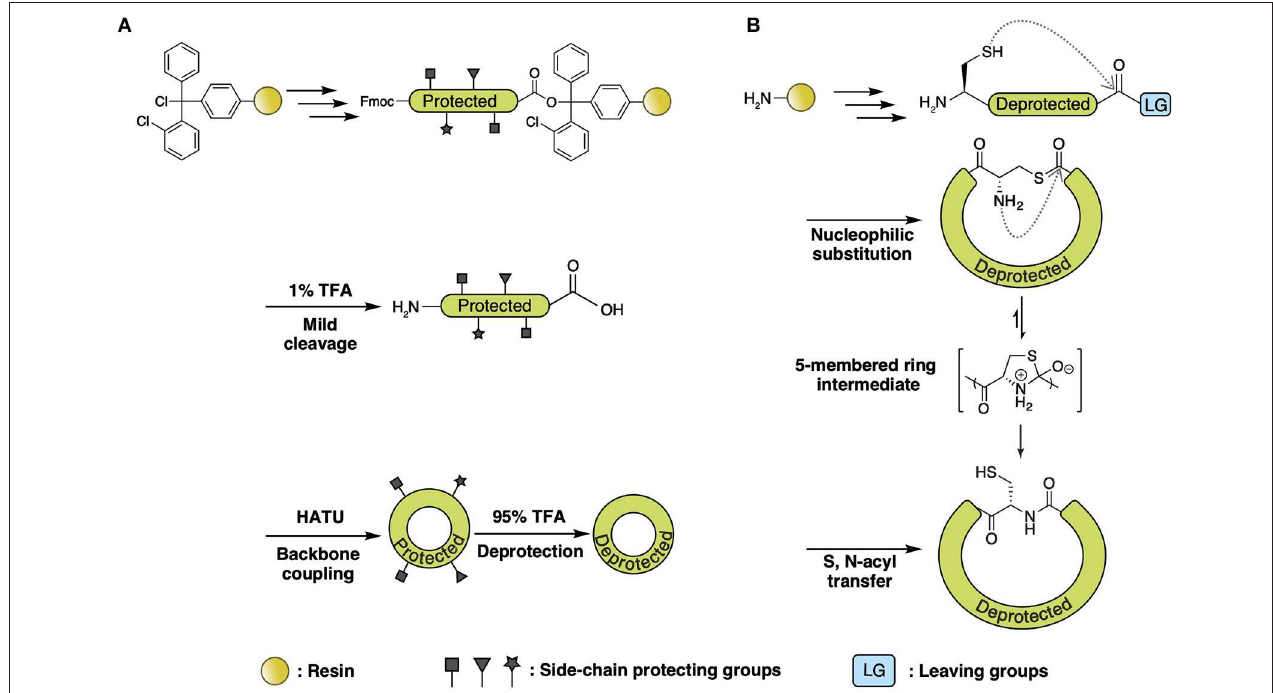
FIGURE 3 | (A) Direct head-to-tail coupling of side-chain-protected peptide. Peptide is assembled on chlorotrityl resin followed by 1% TFA cleavage. Backbone cyclization of the side-chain-protected peptide is performed in solution with uronium salt (HATU) and then deprotected with high-percentage TFA. (B) Backbone cyclization via S-to-N-acyl transfer. Generally, the peptide is deprotected and cleaved from resin using high-percentage TFA, with the C-terminal acyl connected to a good leaving group (i.e., thioester and azide, etc.) generated from either a chemical linker or additional treatment (discussed in the text). Head-to-tail cyclization is achieved with automatic nucleophilic substitution of C-terminal acyl derivatives with free thiol on N-terminal Cys, leading to the formation of a thioester intermediate. The intermediate subsequently rearranges via intramolecular S-to-N acyl transfer, forming a five-membered transition state that then forms into the backbone amide